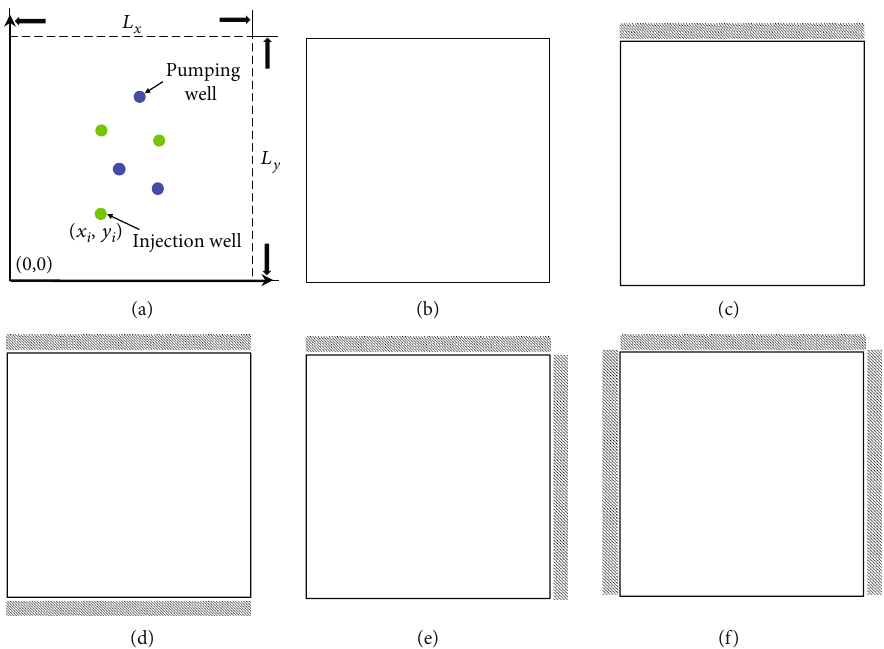
Figure 1: Schematic diagrams of hydrogeological scenarios with di ff erent combinations of impermeable and speci fi ed head boundaries. (a) Pumping (or injection) well with coordinates ð x i , y i Þ is located within a rectangular aquifer. The aquifer has a length of L x and width of L y and is fully bounded by (b) four speci fi ed head boundaries (represented by black straight lines); (c) one impermeable boundary (represented by the shaded rectangle) and three speci fi ed head boundaries; (d) two parallel impermeable boundaries and two parallel speci fi ed head boundaries; (e) two orthogonal impermeable boundaries and two orthogonal speci fi ed head boundaries; and (f) one speci fi ed head boundary and three impermeable